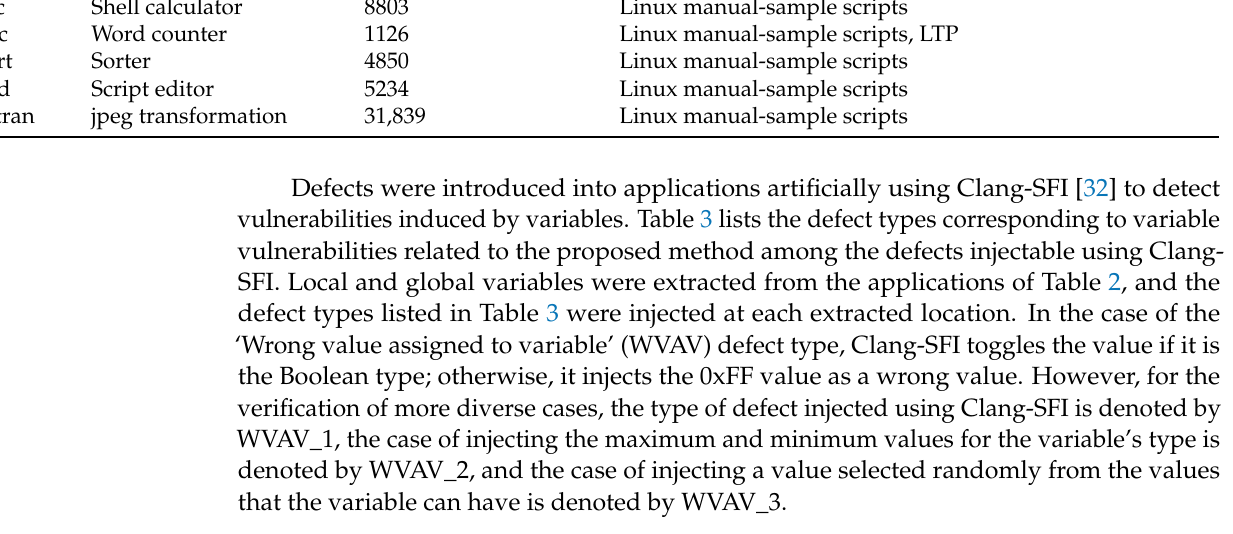
Table 3. Defect injection